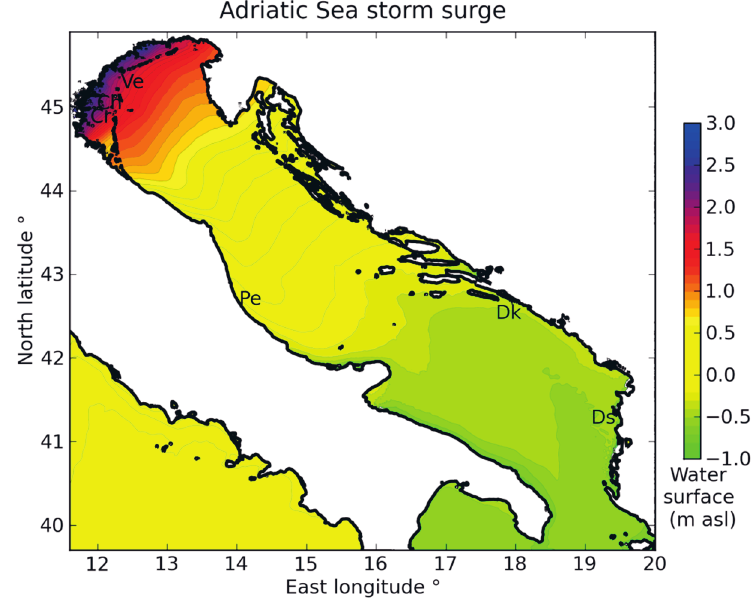
Figure 9. Adriatic surge height with wind from southeast (320°